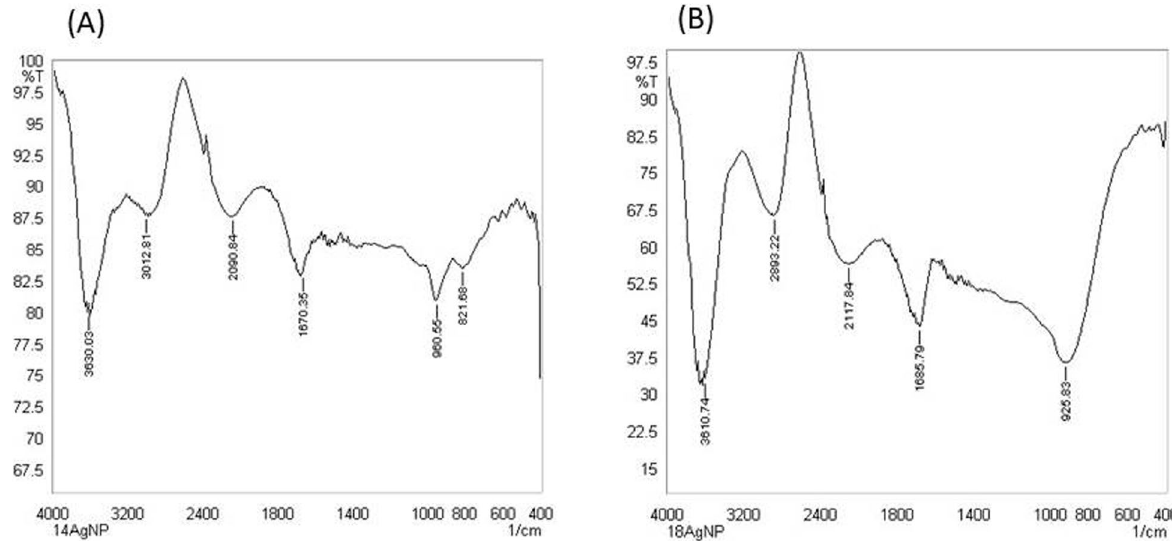
Fig. 4 FTIR result showing graph for 2 ratios; ( A ) 1:4 AgNPs & ( B ) 1:8 AgNPs synthesized from Polygonum plebeium leaf